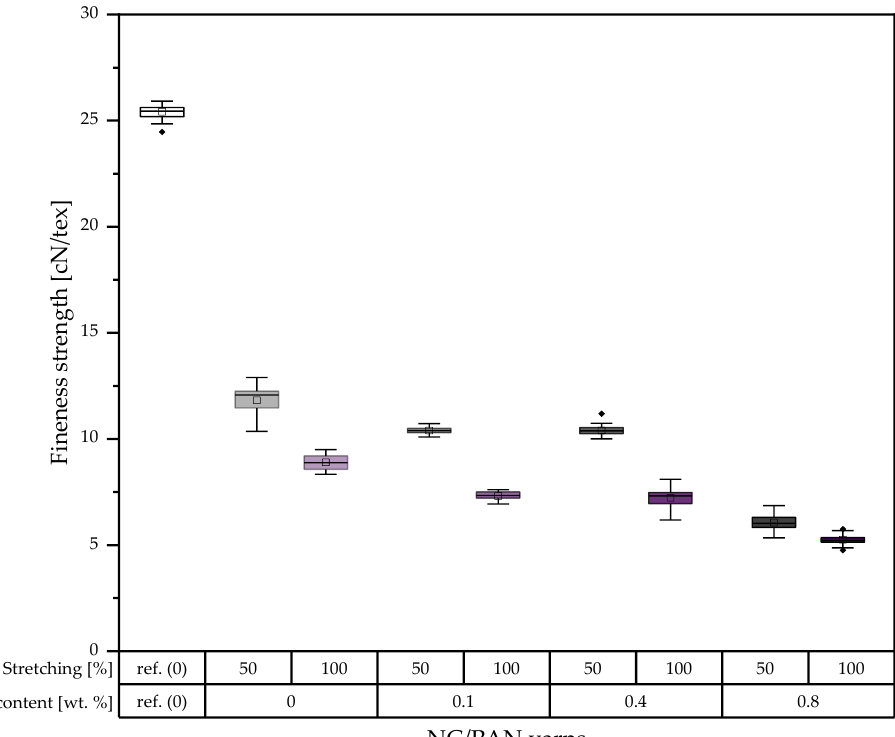
Figure 8. Fineness strength of the developed porous PAN/NC yarns (in the boxes: sorted values between 25% and 75%; between the whiskers: values within 1.5 · IQR; central line: median; square: mean; and rhombus: outlier).